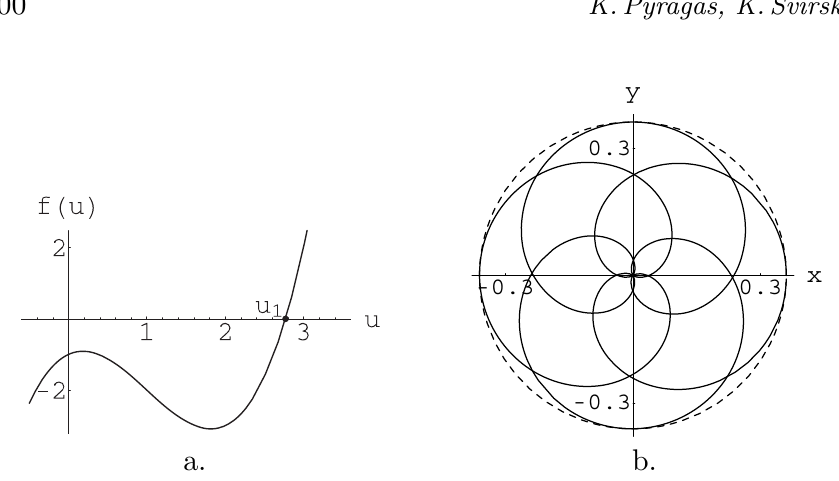
Fig. 2. (a) The roots of the cubic f ( u ) and (b) corresponding trajectory for h < h 1 , u > u 1 . The graphs are given for σ = 4, h 1 = − 1, δ = 1, γ =